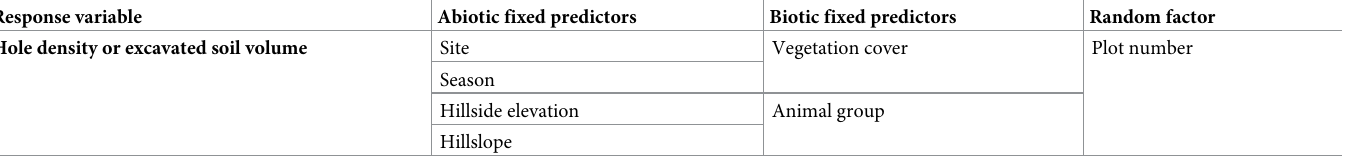
Table 1. Summary of all variables used in the